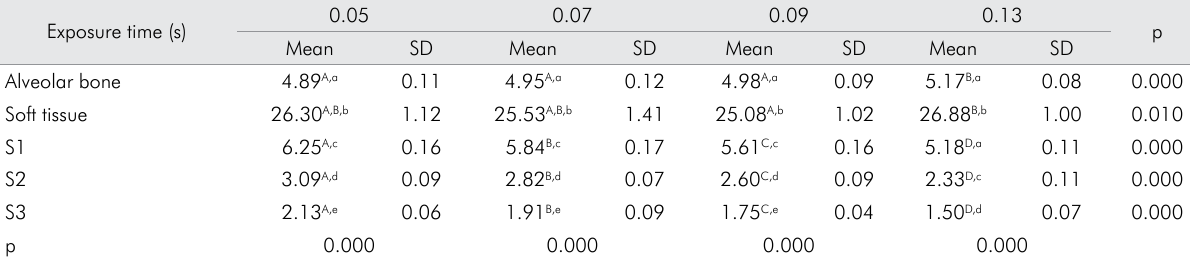
Table 3. Comparison of the noise in the various exposure times and ROIs. Exposure time